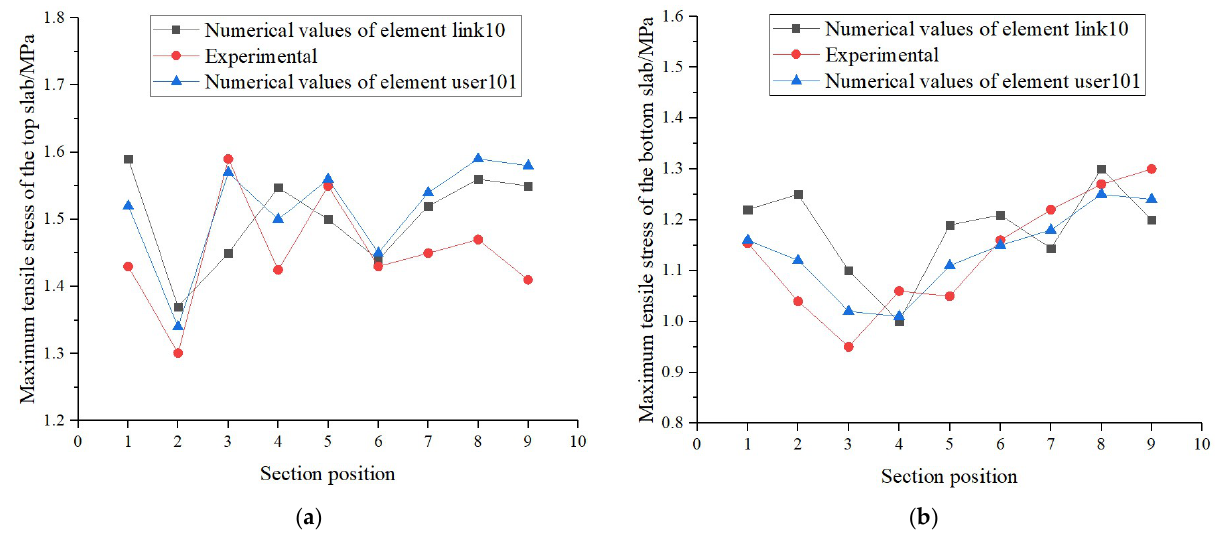
Figure 13. Maximum tensile stresses of the main arch ring: ( a ) Comparison of maximum tensile stresses in the top slab for different elements and experimental values; ( b ) Comparison of maximum tensile stresses in the bottom slab.